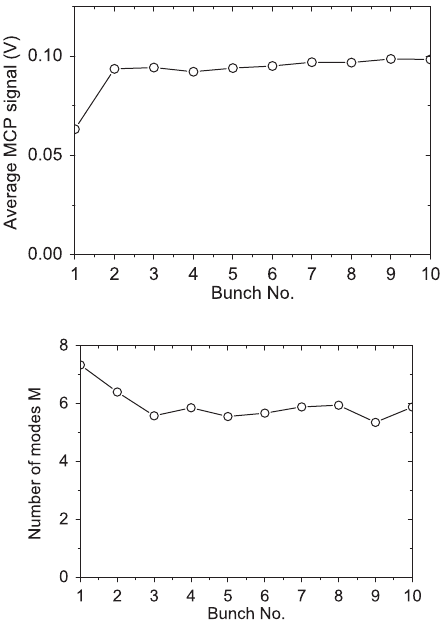
FIG. 7. Experimental data from FLASH operating in the linear regime. Active undulator length is 13.5 m (three undulator modules). Upper plot: The average value of the MCP signal versus the position of the bunch in the train. Lower plot: Number of modes in the radiation pulse versus the position of the bunch in the